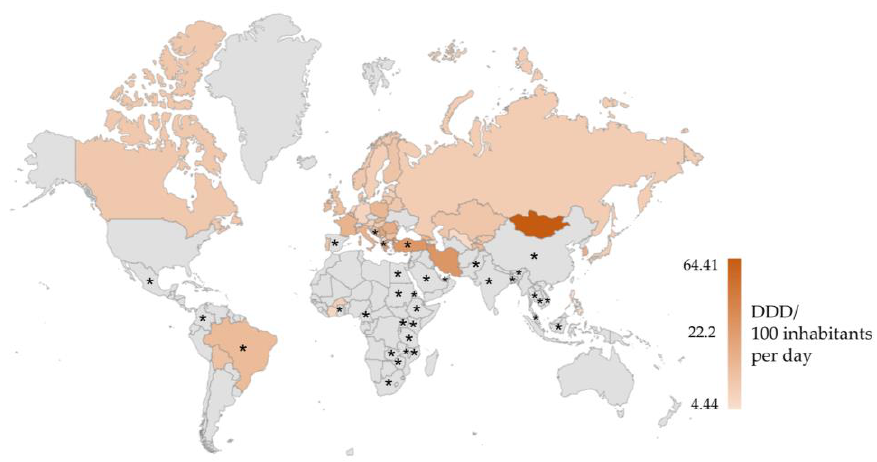
Figure 1. Map of total antibiotic consumption in 2015–2016, based on data acquired by the World Health Organization (WHO) from 65 countries [4]. DDD—daily defined dose. The black asterisk (*) marks countries where the consumption of antibiotics is not properly controlled, and antimicrobials can be purchased without a prescription [6 – 10].